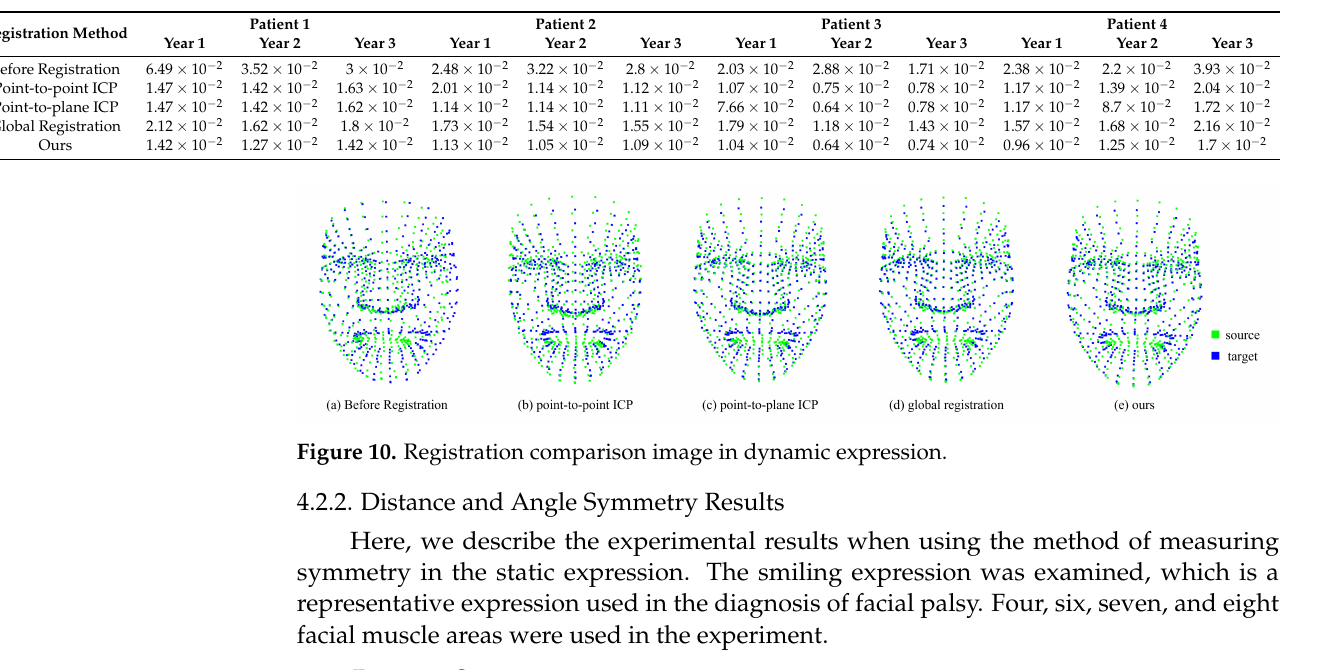
Table 5. Registration comparison for dynamic expression (neutral-smile).